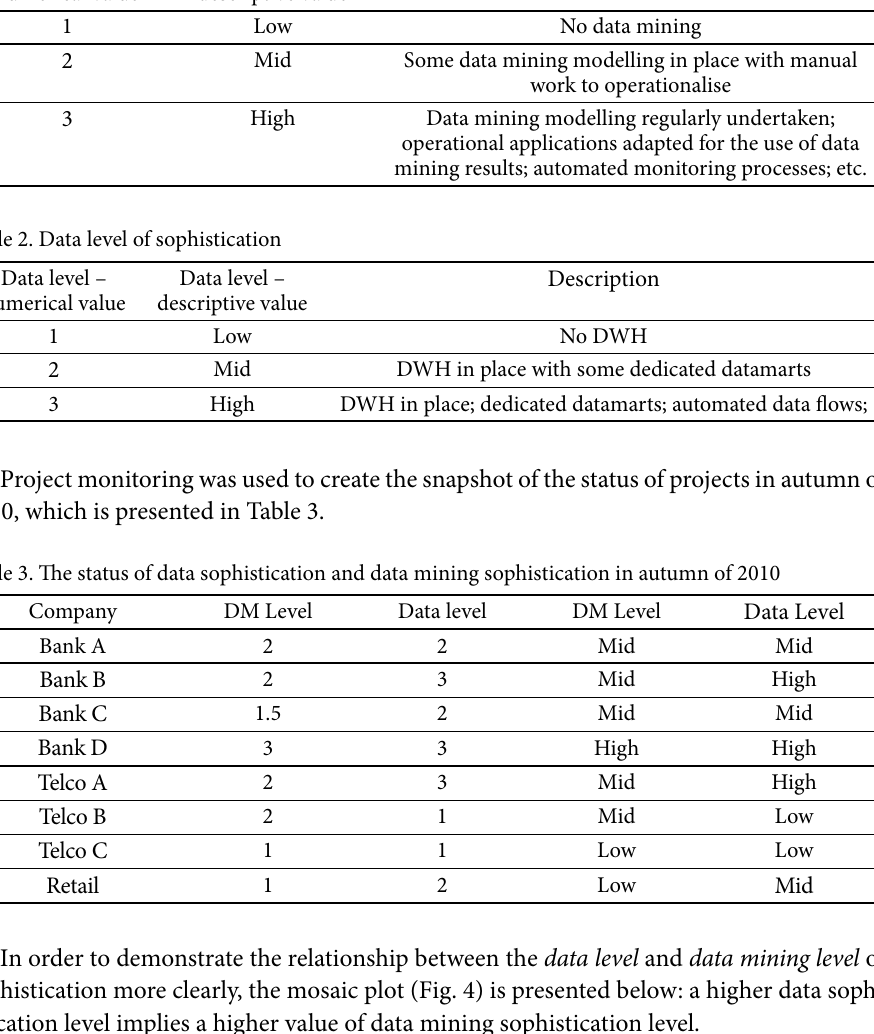
Table 1. The level of data mining sophistication Data mining level – numerical value